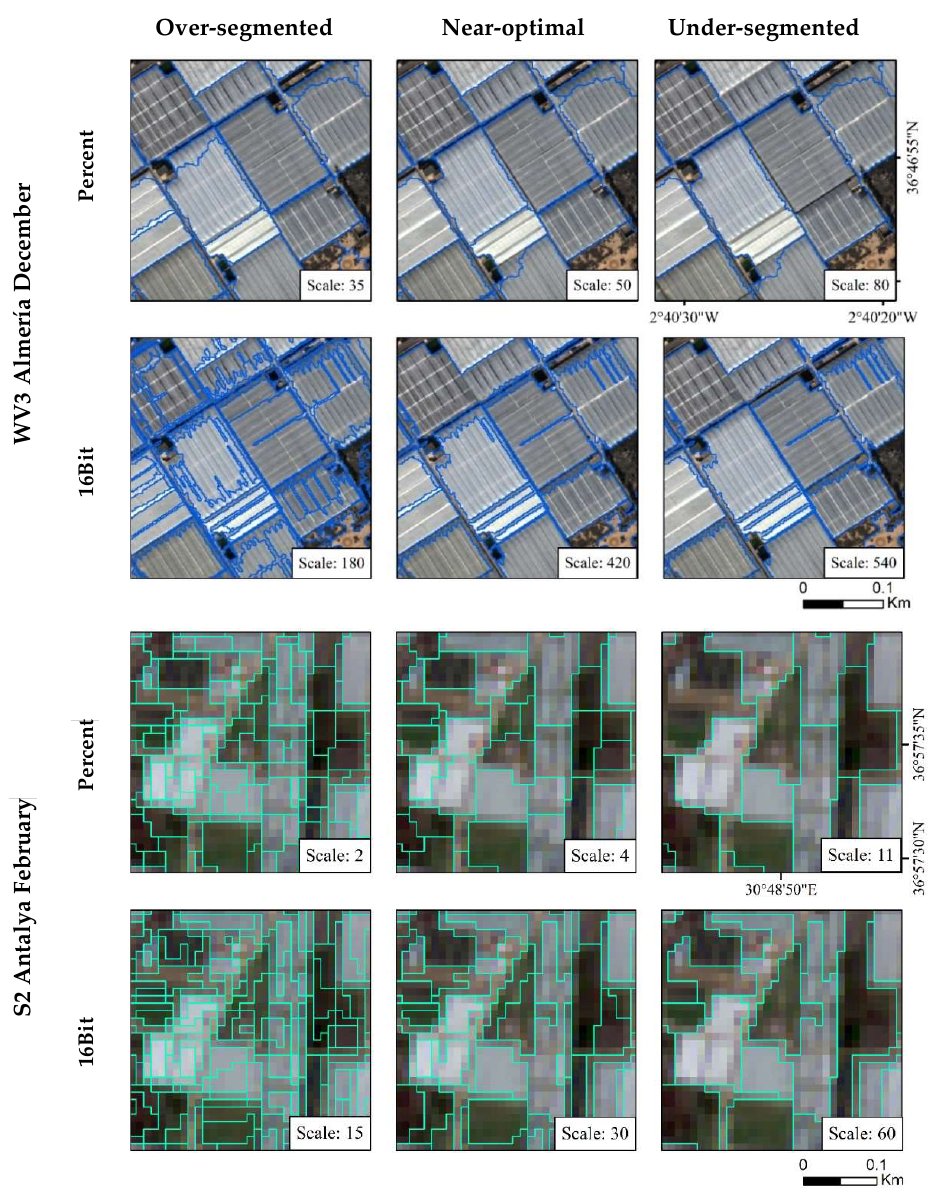
Figure 3. Some sample areas of the Almería and Antalya study sites corresponding to over-segmentation ( left ), near-optimal segmentation ( center ), and under-segmentation ( right ).